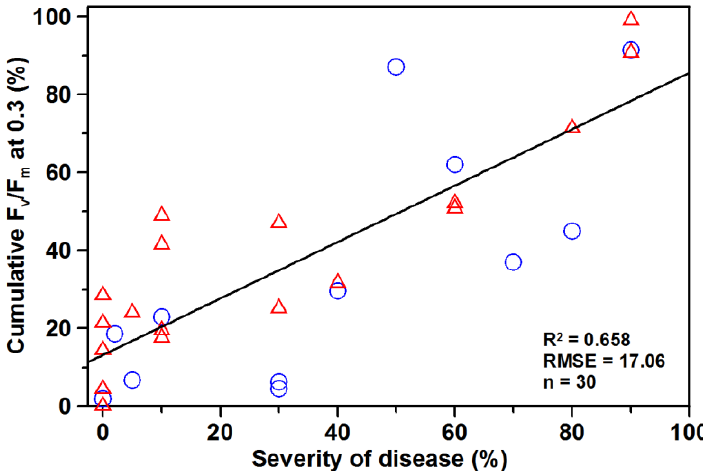
Figure 4. Correlation between the cumulative F obtained from visual rating (circles: 23 June 2009, triangles: 24 June